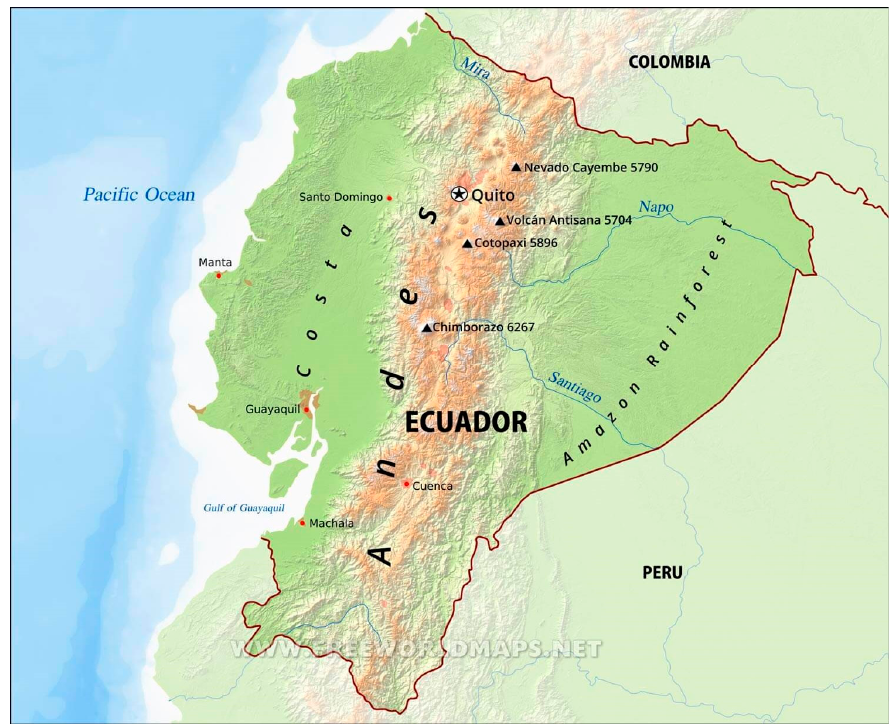
Figure 8. Map of Ecuador with the Andean region of Highland Ecuadorian Spanish where /s/ voicing occurs. Available online: https://www.premiumtimesng.com/foreign/world-foreign/2801 23-23-die-in-bus-accident-in-ecuador.html (accessed on 20 November